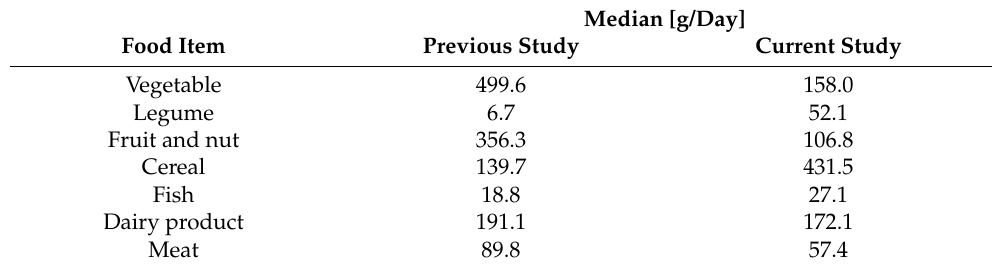
Table 5. Comparison of the median values used in a previous study with those in the current study.